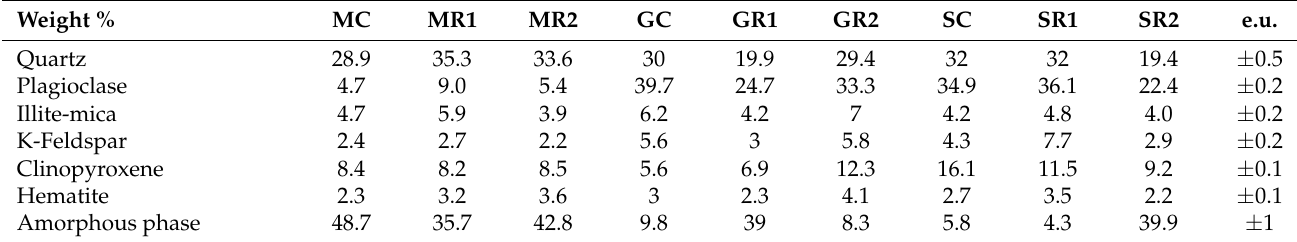
Table 5. Phase composition of fired clay